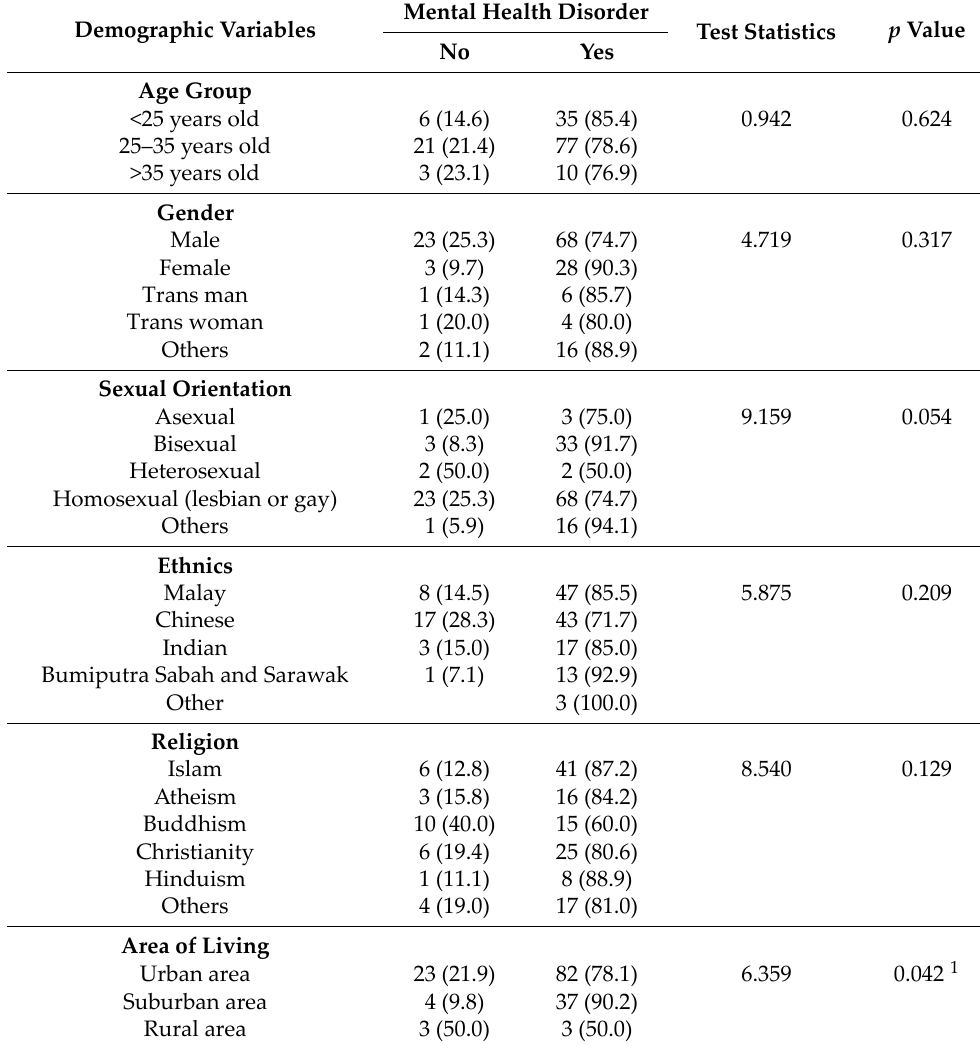
Table 3. Association of sociodemographic and primary coping styles among the LGBT+ community in